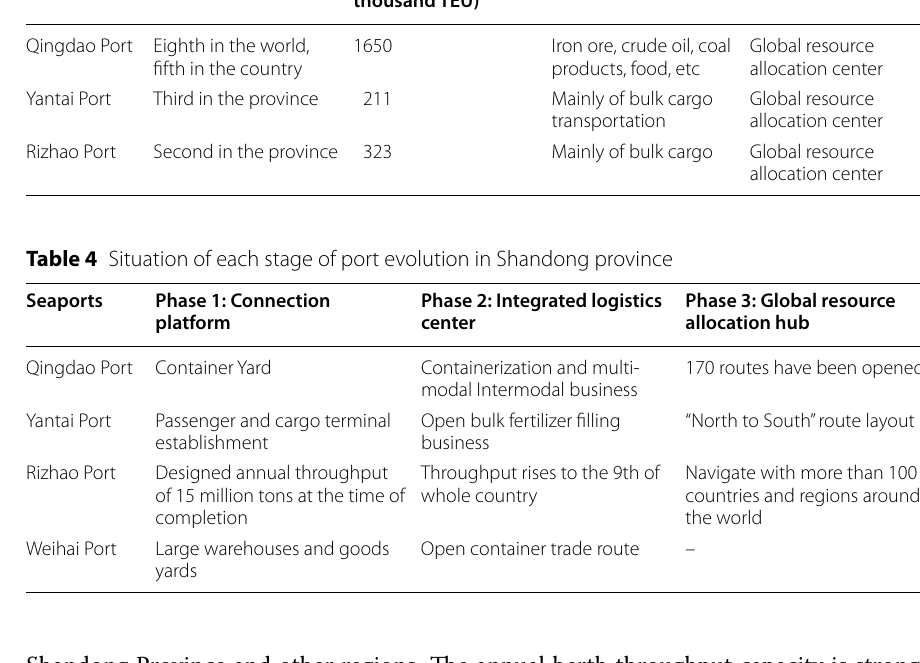
Table 3 Construction of large ports in Shandong province (as of 2018) Seaports Throughput of container